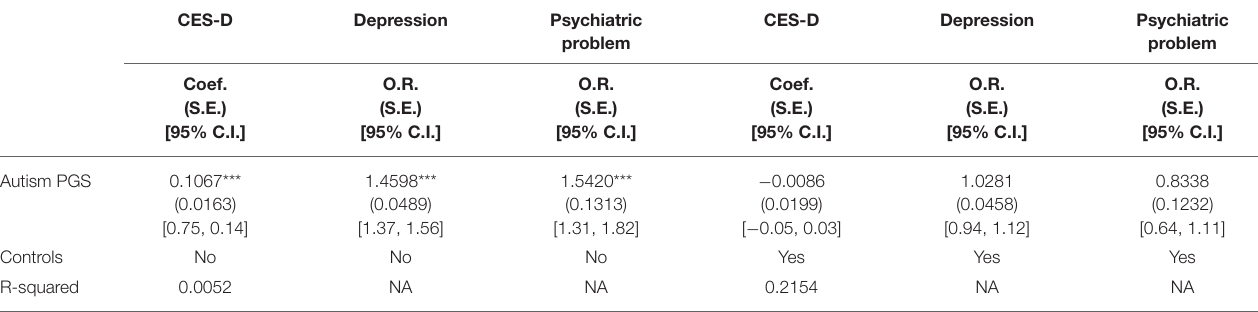
TABLE 2 | The correlation between autism polygenic score and mental health. CES-D Depression